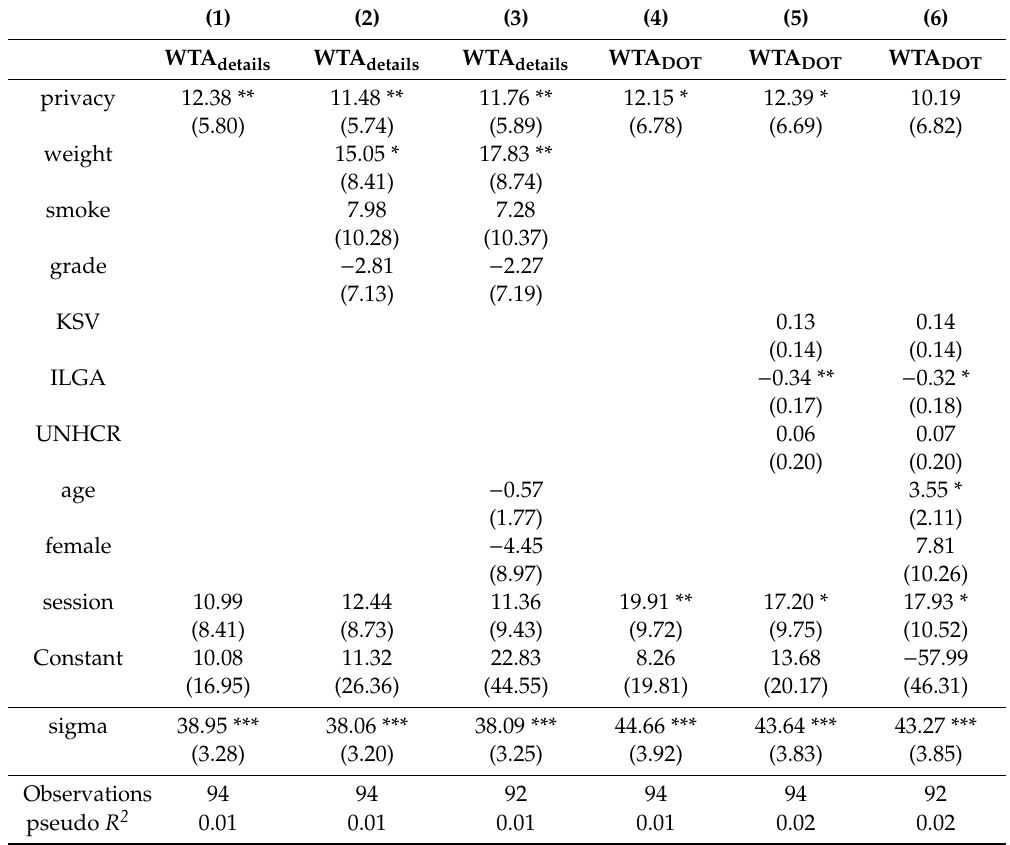
Table A1. Tobit regressions of WTA on self-stated privacy behavior (additive a1-a5) and information at stake.